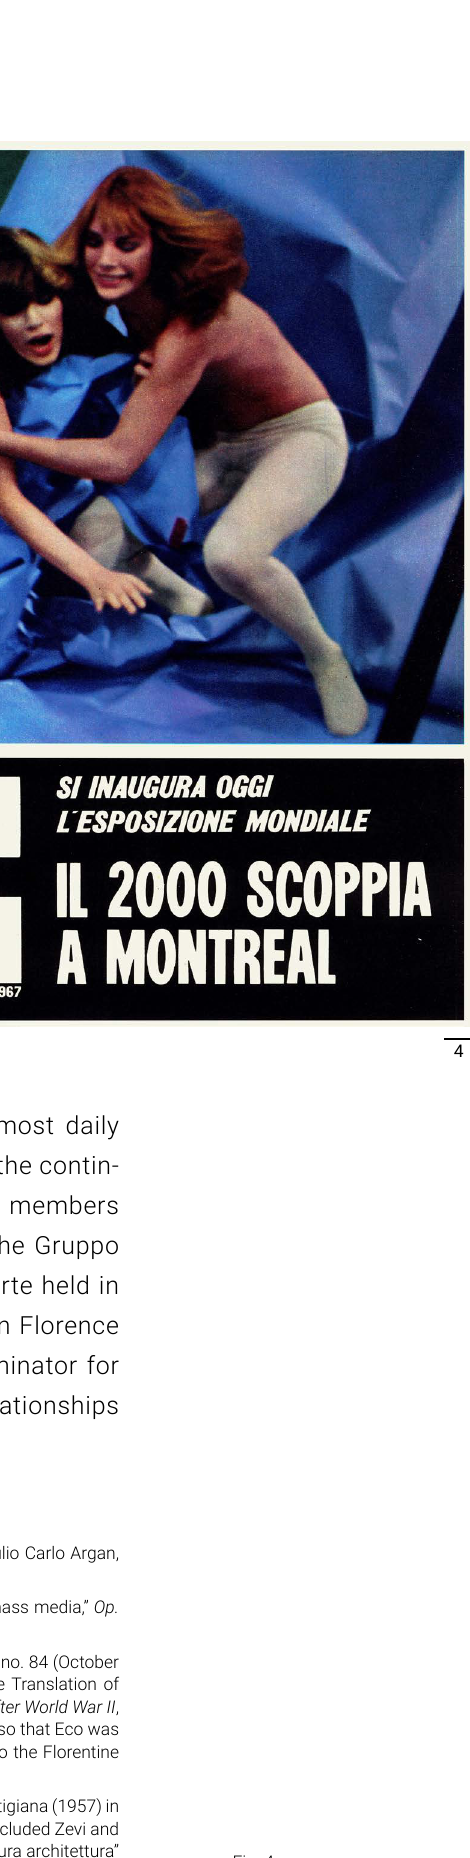
Fig. 4 The cover of L’Espresso of 30th April